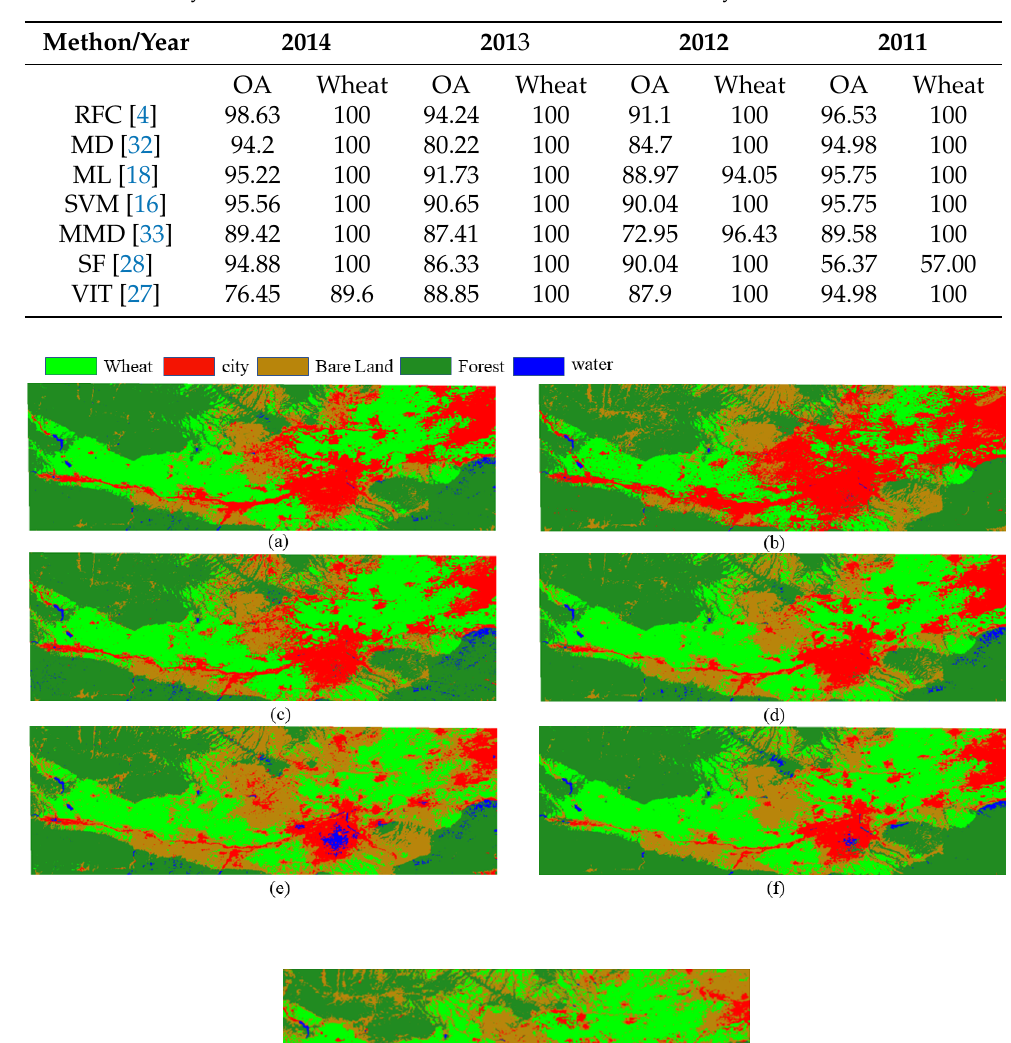
Table 3. Accuracy results after fusion of different methods in different years.